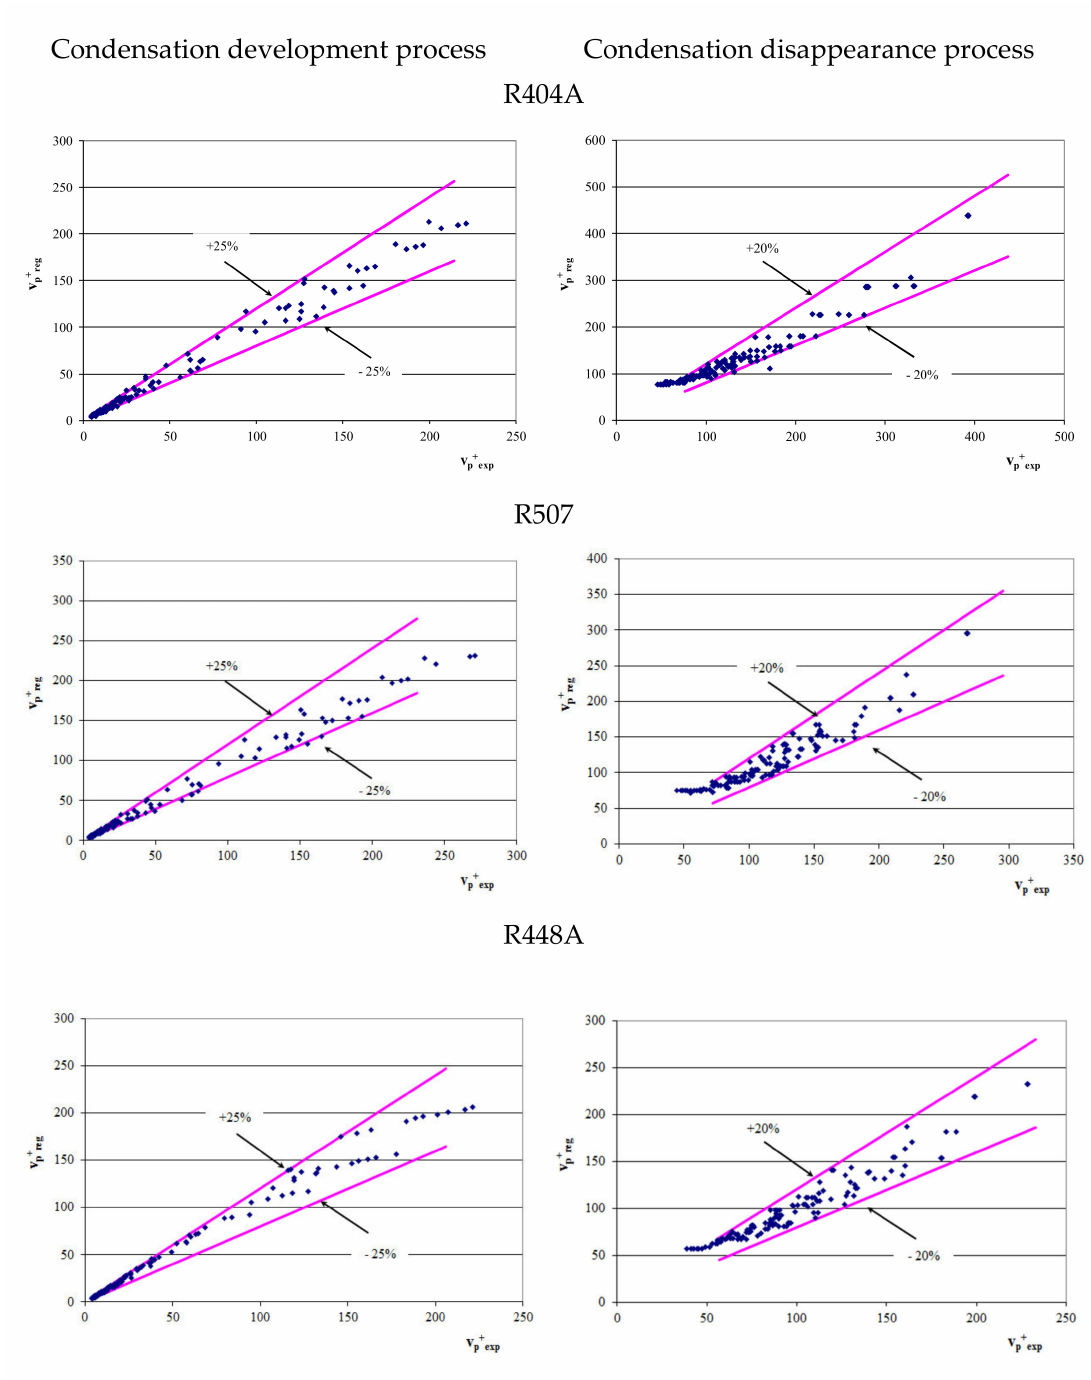
Figure 6. Scope of the compliance of the calculated and experimental results for the σ 2 variance and r-Pearson significance coefficients of the investigated R404A, R507 and R448A refrigerants for the dimensionless propagation velocity of pressure instabilities v + p